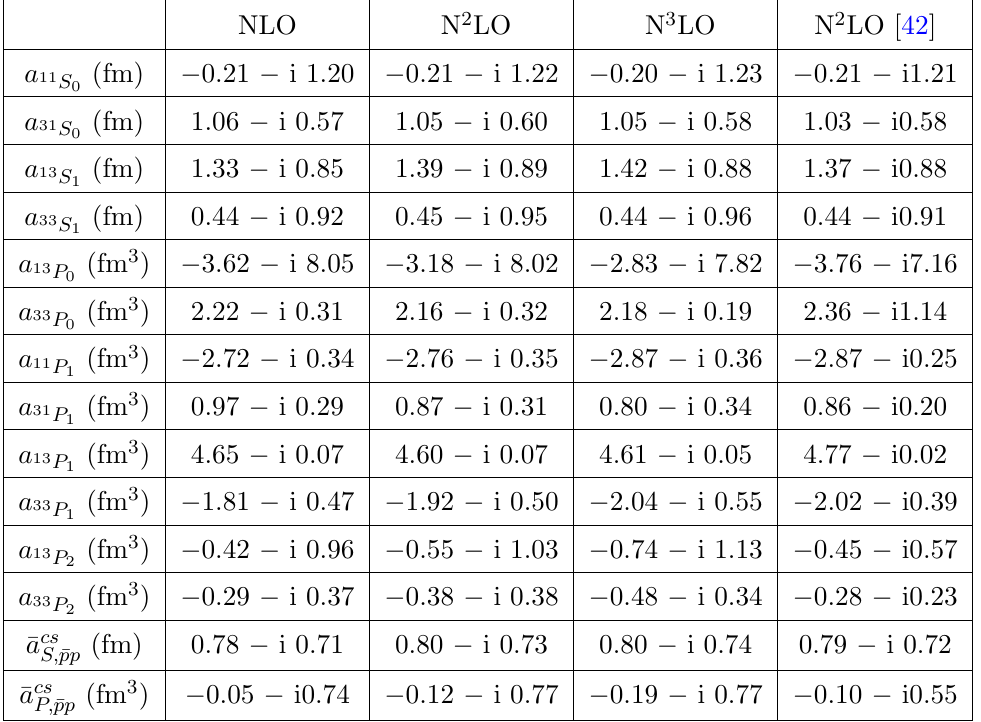
Table 3 . Scattering lengths and volumes for di(cid:11)erent partial waves for the chiral potentials with R = 0 : 9 fm. (cid:22) a cs and (cid:22) a cs are spin-averaged results obtained from a calculation in particle basis S; (cid:22) pp P; (cid:22) pp including the Coulomb force. For comparison N 2 LO predictions of our previous chiral potential are included, based on the cuto(cid:11) combination ((cid:3), ~(cid:3)) = (450,500) MeV